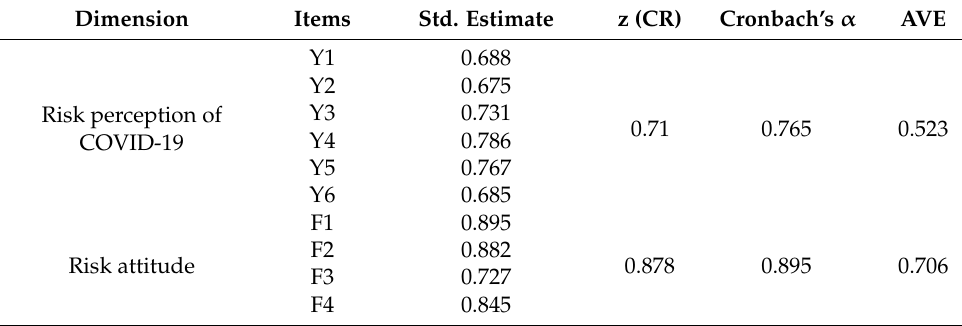
Table 2. Reliability and aggregation validity of the